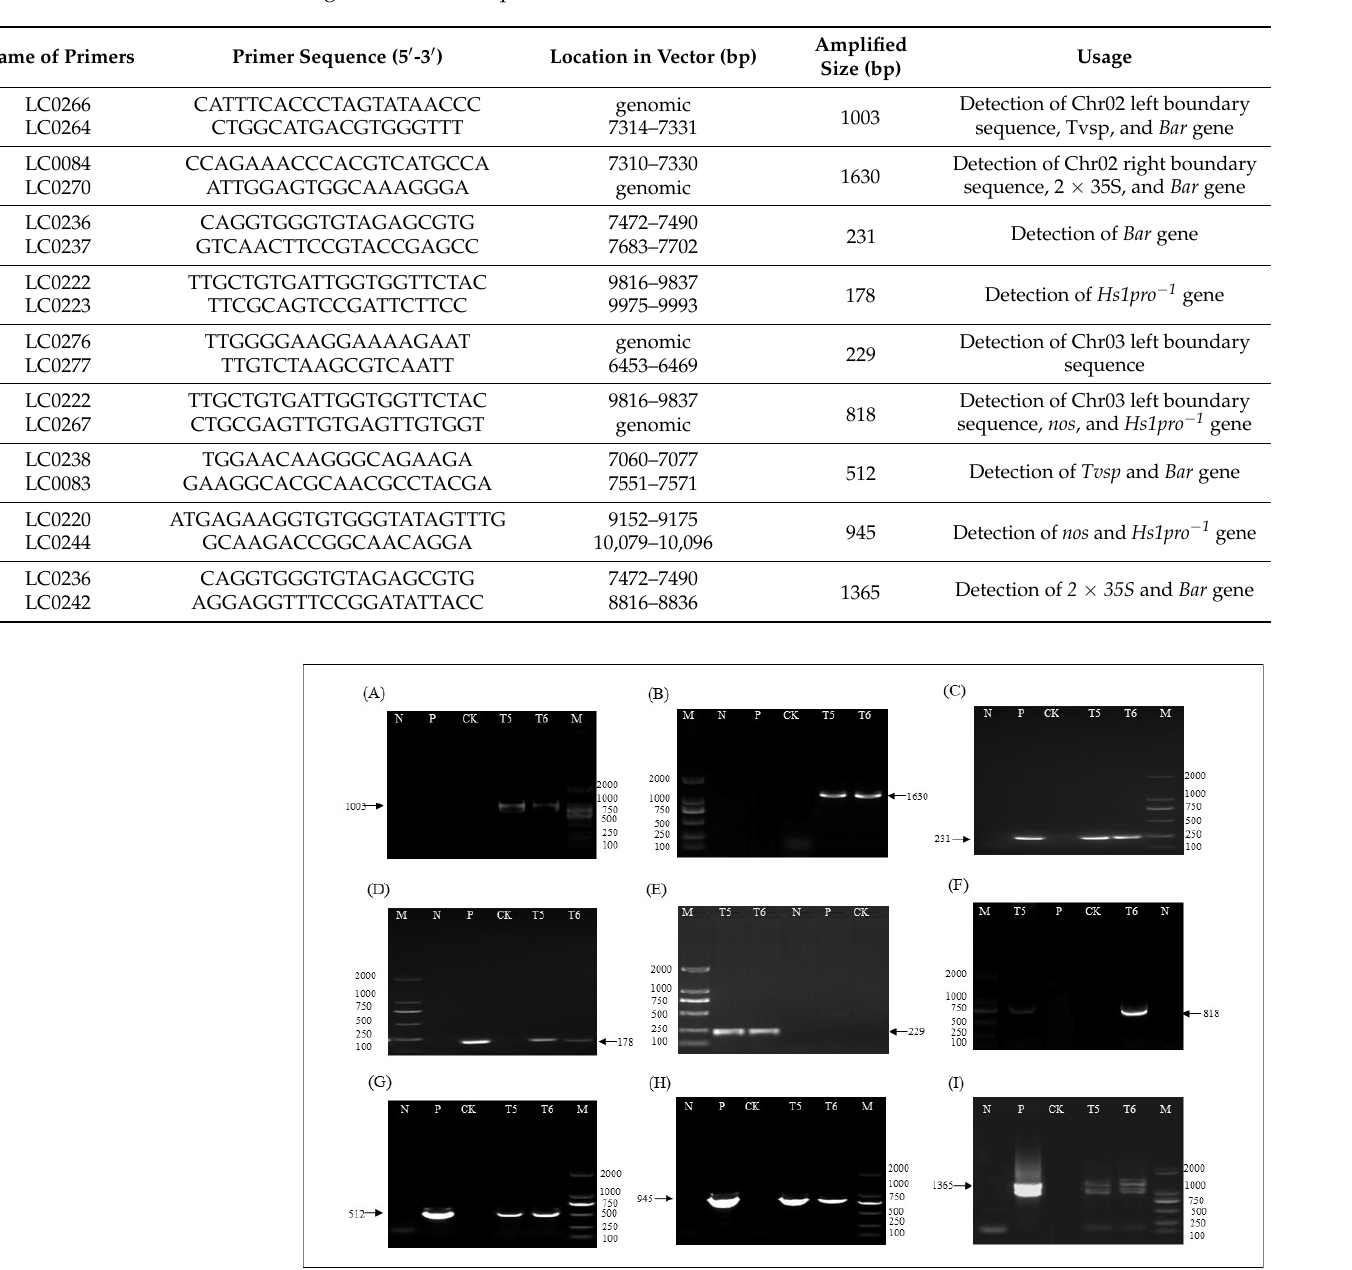
Table 3. Name of primers, primer sequence (5 (cid:48) -3 (cid:48) ), location in vector (bp), amplified size (bp), and usage for inserted sequence verification.